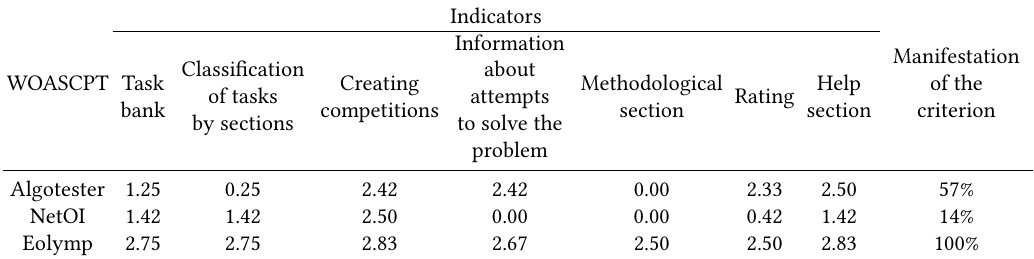
Table 4 Information and didactic criterion of web-oriented automated systems for checking programming tasks and its